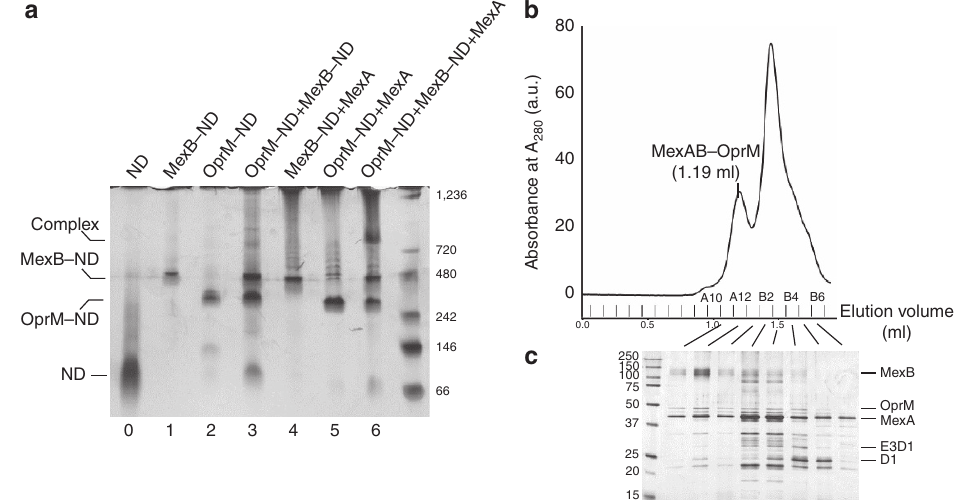
Figure 3 | Native PAGE analysis and purification of the tripartite MexAB–OprM assembly. ( a ) Electrophoretic mobility shift assay of individual and mixed components. OprM–ND and MexB–ND were mixed in the presence and in the absence of MexA. An extra band was observed when the three components were present in the sample. Lane 0, ND; lane 1, MexB–ND; lane 2, OprM–ND; lane 3, MexB–ND and OprM–ND; lane 4, MexB–ND and MexA; lane 5, OprM–ND and MexA; lane 6, MexB–ND, OprM–ND, and MexA. Proteins were separated by native PAGE and stained with PlusOne Silver Staining Kit. ( b ) Analytical size-exclusion chromatography (SEC) analysis of the mixed components. ( c ) SDS–PAGE analysis of the indicated SEC peak fractions. The molecular mass of each marker protein (in kilodalton) is indicated on the right ( a ) and on the left ( b ). NATURE COMMUNICATIONS|7:10731|DOI: